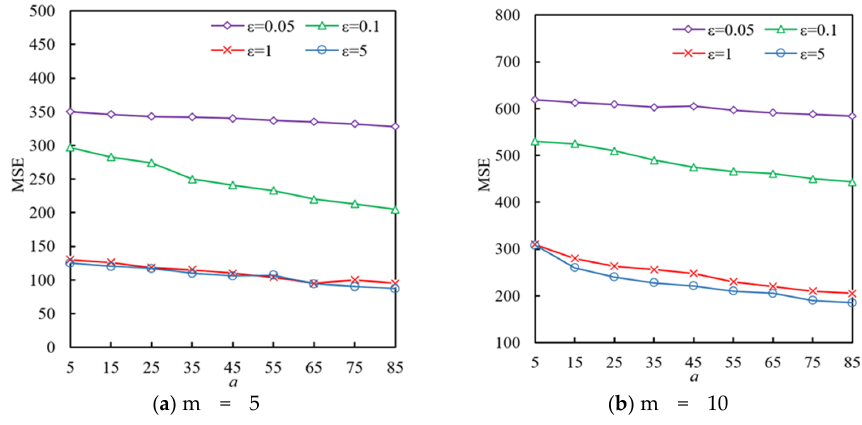
Figure 5. Change trend of SSE for the Adult dataset.